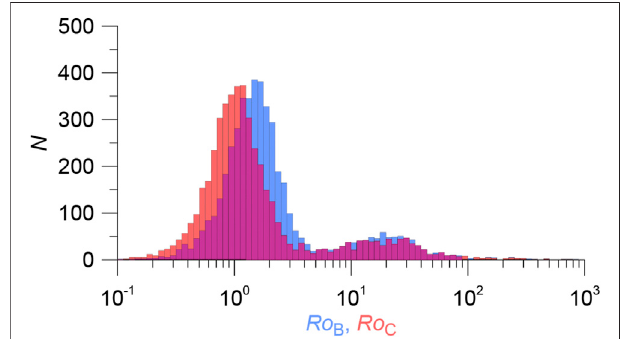
FIGURE 10 | Distribution of the metric Ro C (Eq. 6) with correlations and systematic shifts (red) and basic metric Ro B (Eq. 4) (blue, the same as in Figure 4